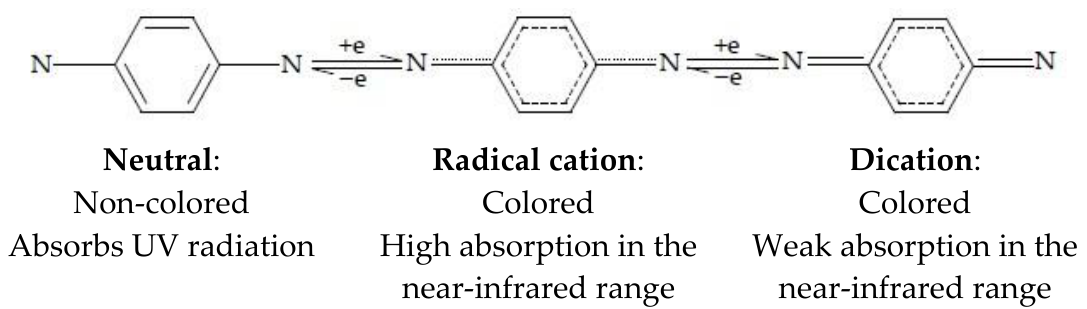
Figure 9. Redox chemistry of Phenylenediamine (Wurster’s blue), description of optical behavior in redox states.